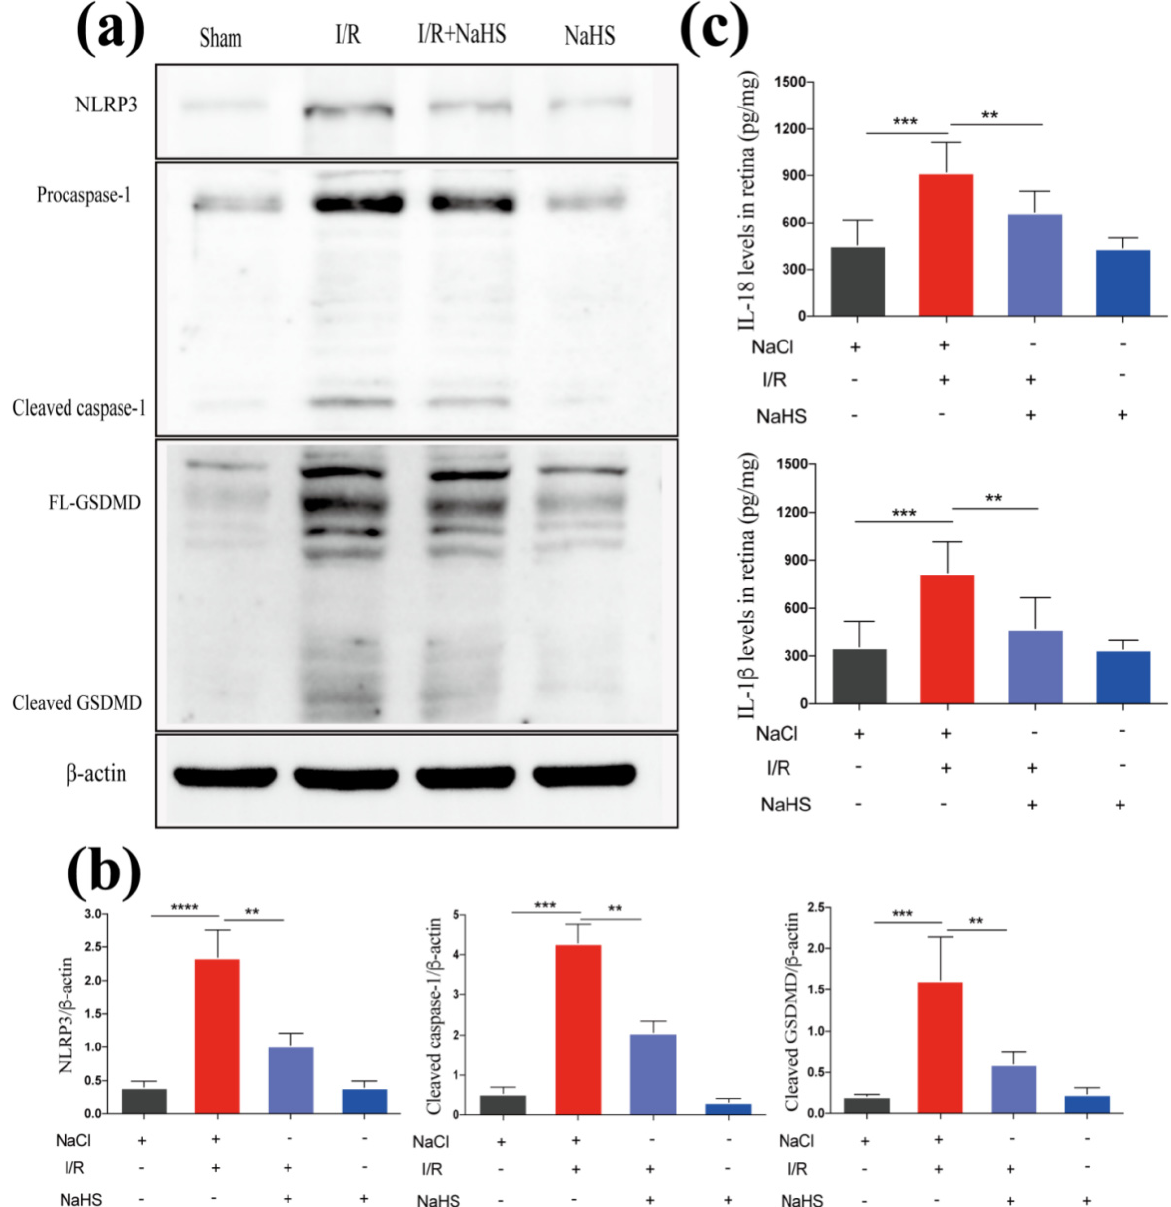
Figure 4. NaHS suppressed I/R-induced inflammasome-dependent pyroptosis in the rat retina. ( c ) ELISA analysis of proinflammatory cytokines in the retina from I/R rat ( n = 5). ( a ) Western blot analysis of NLRP3, caspase-1, and GSDMD in the retina. ( b ) Quantitative analysis of expression levels of NLRP3, caspase-1, and GSDMD in the retina ( n = 3). Data are represented as means ± SD, ** p < 0.01, *** p < 0.001, **** p < 0.0001. 3.5. NaHS Prevented Neuron Pyroptosis in Rat Brain Cortex after Cerebral I/R